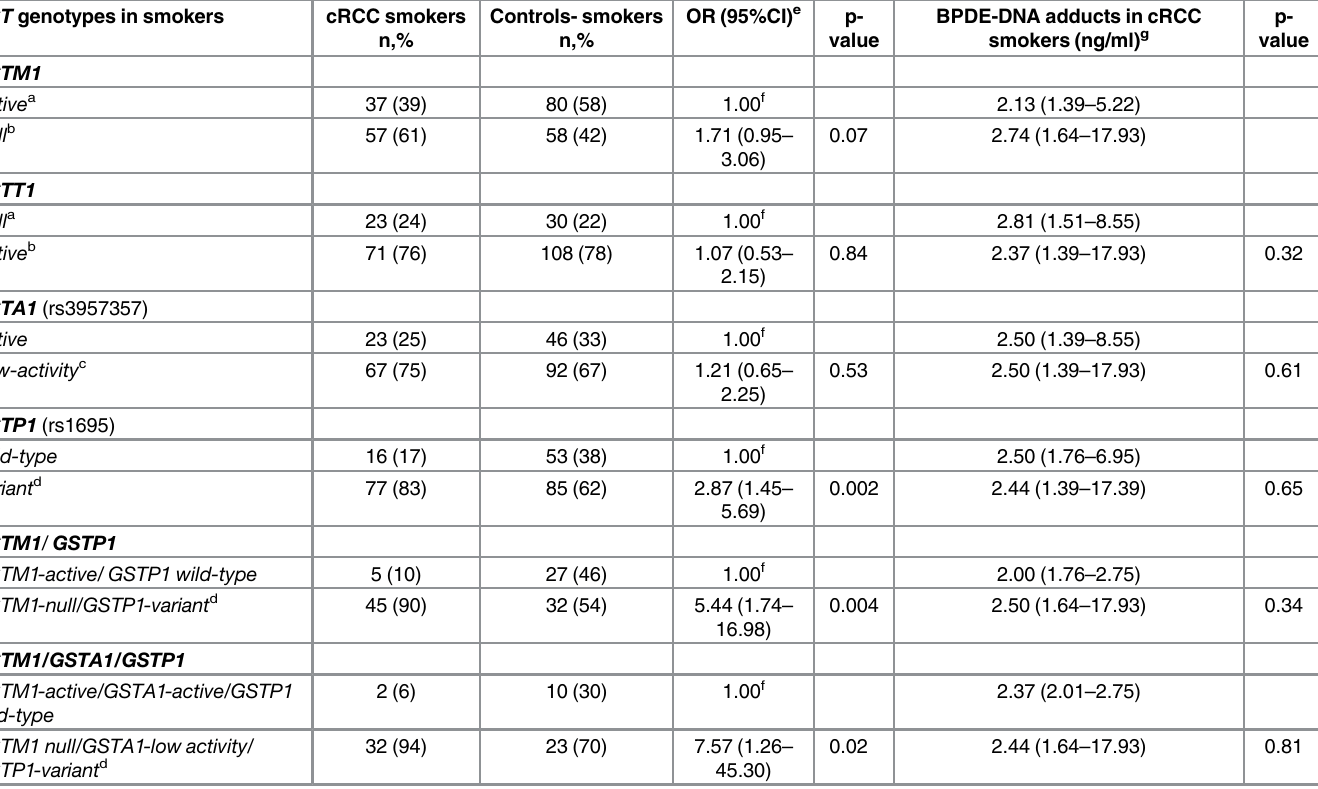
Table 6. The association between GST genotypes and the levels of BPDE-DNA adducts in cRCC smokers. GST genotypes in